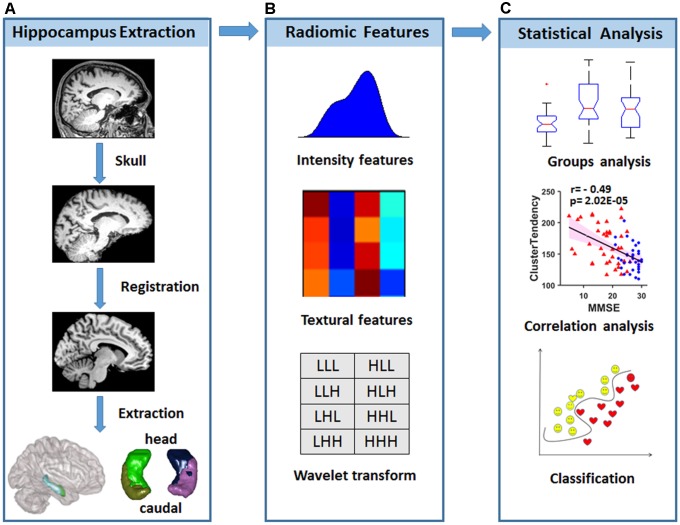
Diagram of data processing and statistical analyses. (A) Strategy for hippocampal subregion extraction from high-resolution structural MRI. (B) Intensity features and textural features were extracted from the images, and wavelet transformation was achieved in each hippocampal subregion. (C) Statistical analysis was used to find radiomic features that were different among the groups, and correlations with the MMSE were performed to evaluate the relationship between radiomic features and cognitive performance. A classification analysis was performed to determine whether radiomic features could be used for diagnosis.